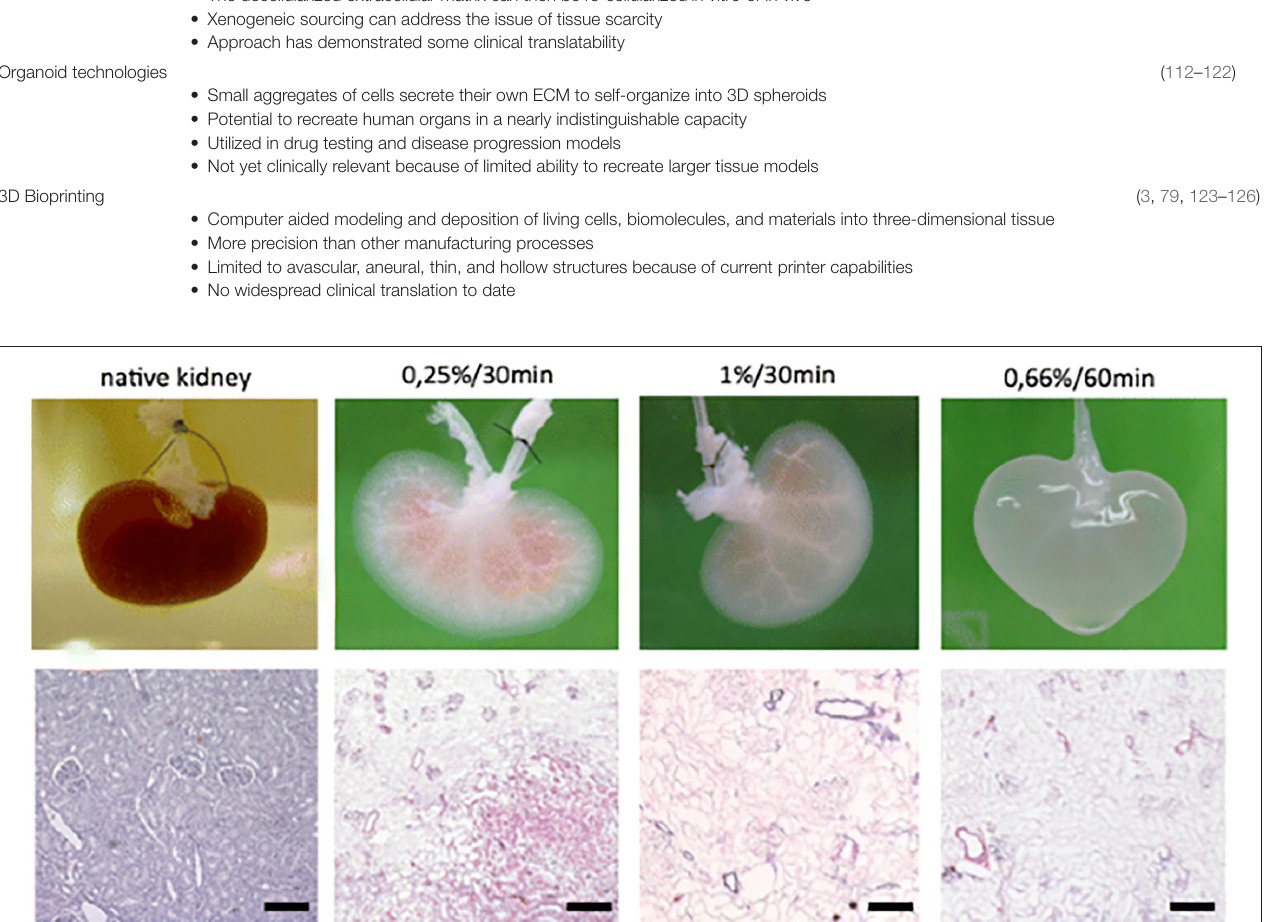
potentially cytotoxic by inhibiting cell proliferation during the recellularization process (102). The last stage is sterilization,